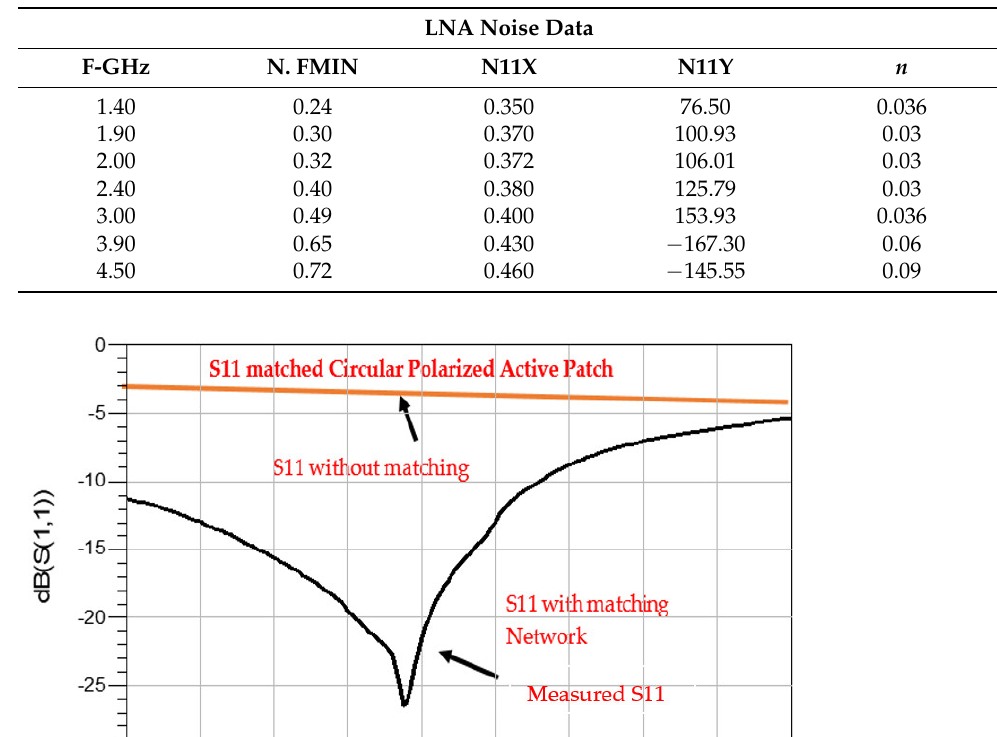
Figure 12. Gain , S21, of the Circular Polarized Active Receiving Sensor.